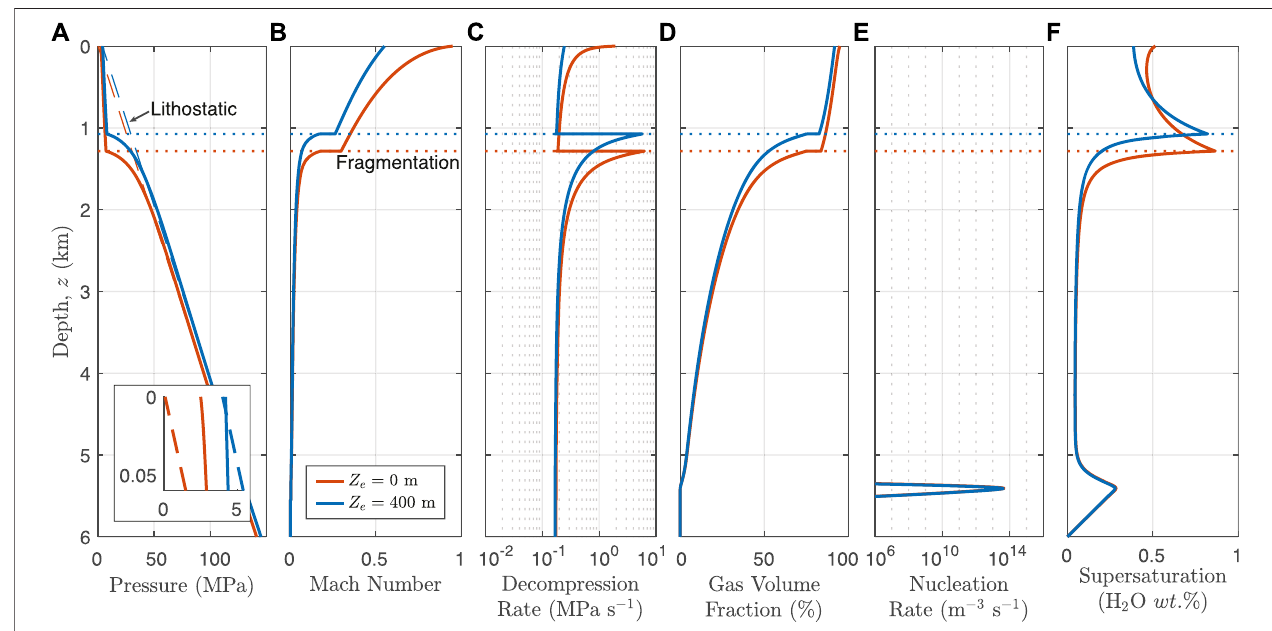
FIGURE4| Exampleconduitmodeloutputfromthe Reference set(see Table2 )versusdepthbelowtheventforapairofsimulations:redlinesshowa “ dry ” control run with a c = 53.8 m, Z e = 0, and Q 0 = 1.6 × 10 8 kg/s. Blue lines show a hydrovolcanic scenario with a c = 53.8 m, Z e = 400 m, and q c = 1.53 × 10 8 kg/s (blue lines). (A) Magma pressure. Inset:pressure in thetop 60 m ofthe conduit (same units aspanel (A) axes), highlighting the vent overpressure of the control run versus thepressure- balanced vent of the hydrovolcanic run. (B) Mach number. (C) Decompression rate. (D) Gas Volume Fraction. (E) Bubble Nucleation Rate. (F) Supersaturation of dissolved water (i.e., difference between dissolved water c H and water solubility). 2 O